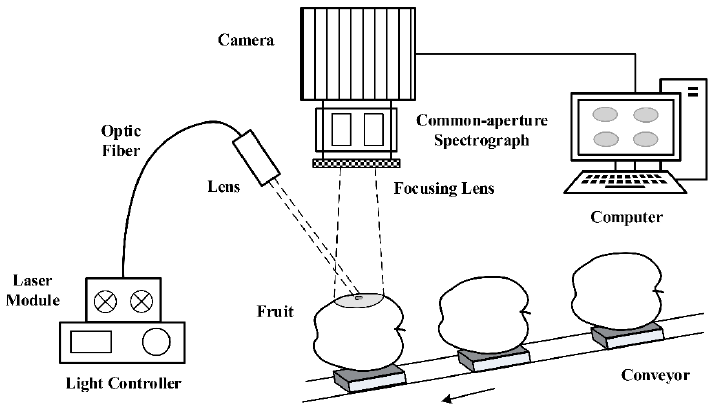
Figure 7. Schematic of a laser-based multispectral imaging prototype for real-time scattering measurement.